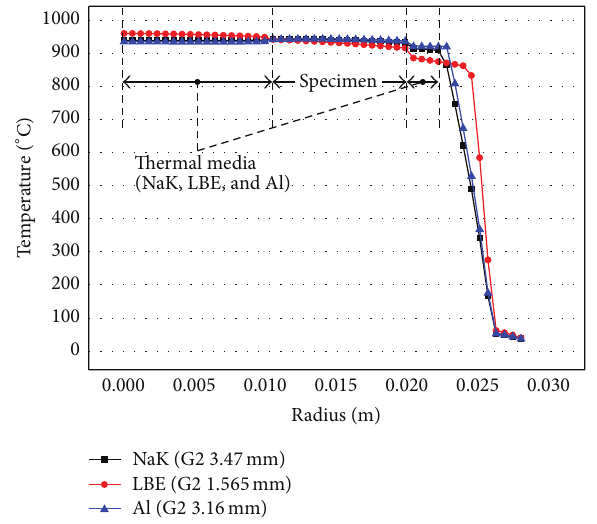
Figure 5: Temperature distribution of the capsules with three kinds of thermal